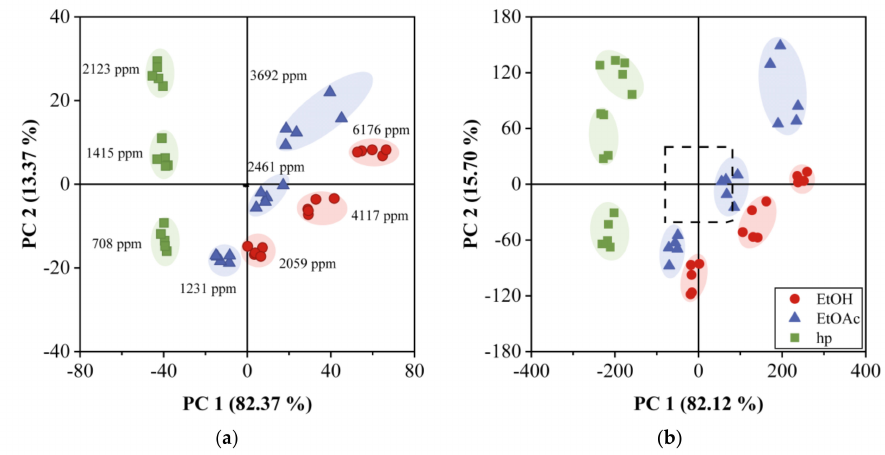
Figure 6. Principal component analysis for QCM gas sensor array response. ( a ) 12QCM-SA and